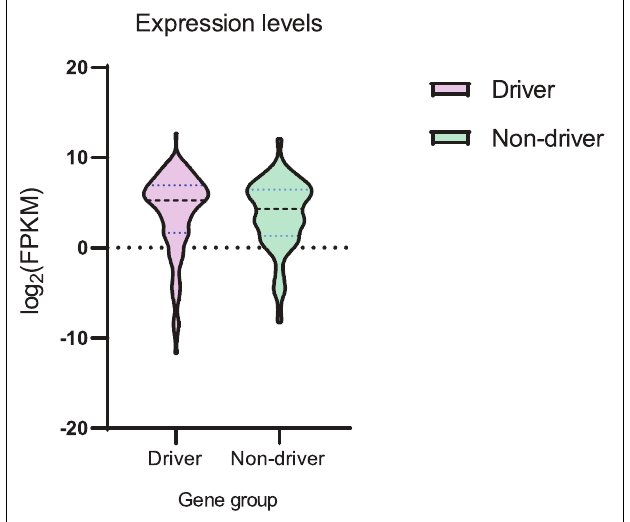
FIGURE 5 | Violin plot of mRNA expression (FPKM values) for sets of driver and non-driver genes. Log 2 transformation was used.